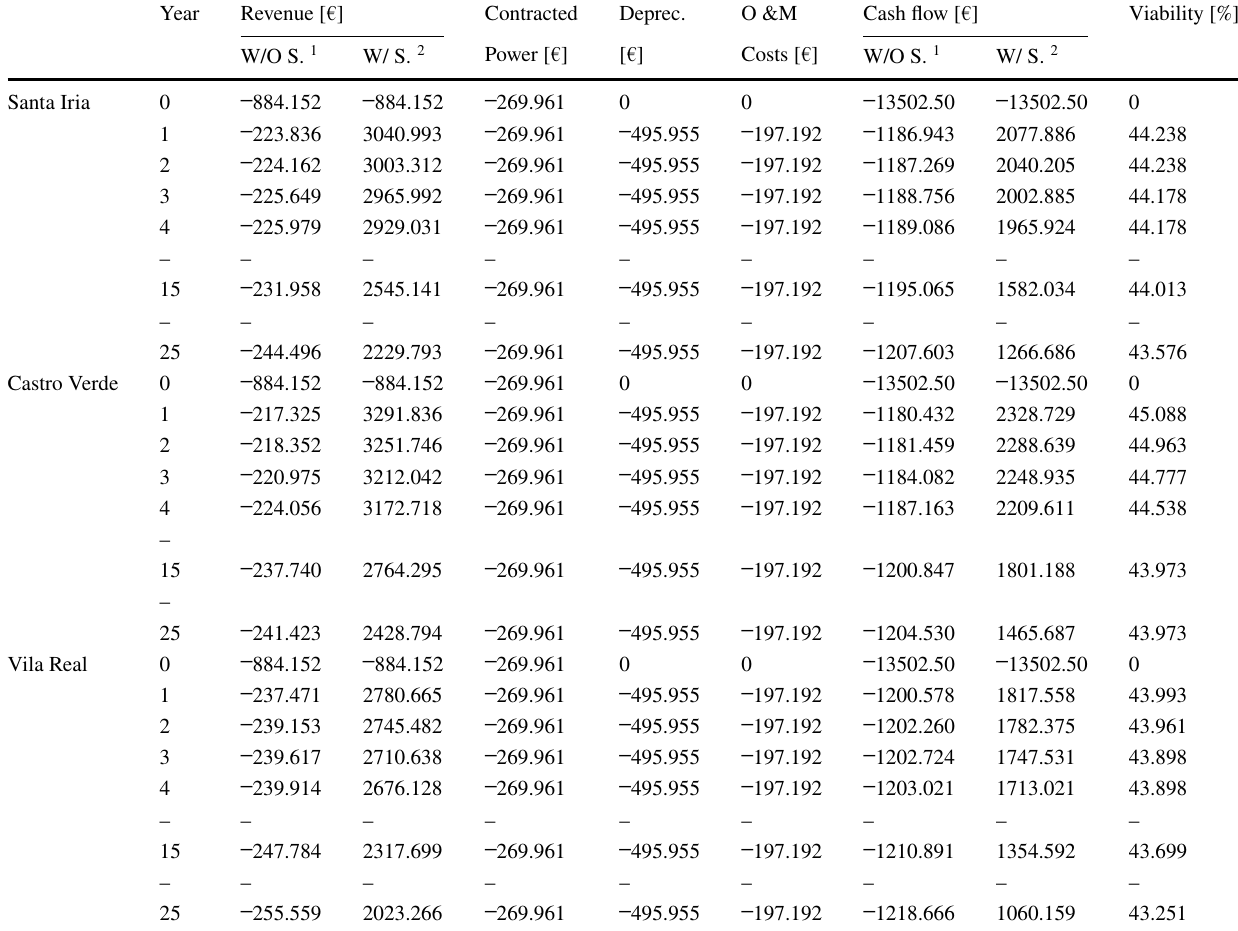
Table 9 CIGS: Initial Investment = 12398.863 €: 1 Without selling the surplus energy to the grid; 2 With selling the surplus energy to the grid Year Revenue [€] Contracted